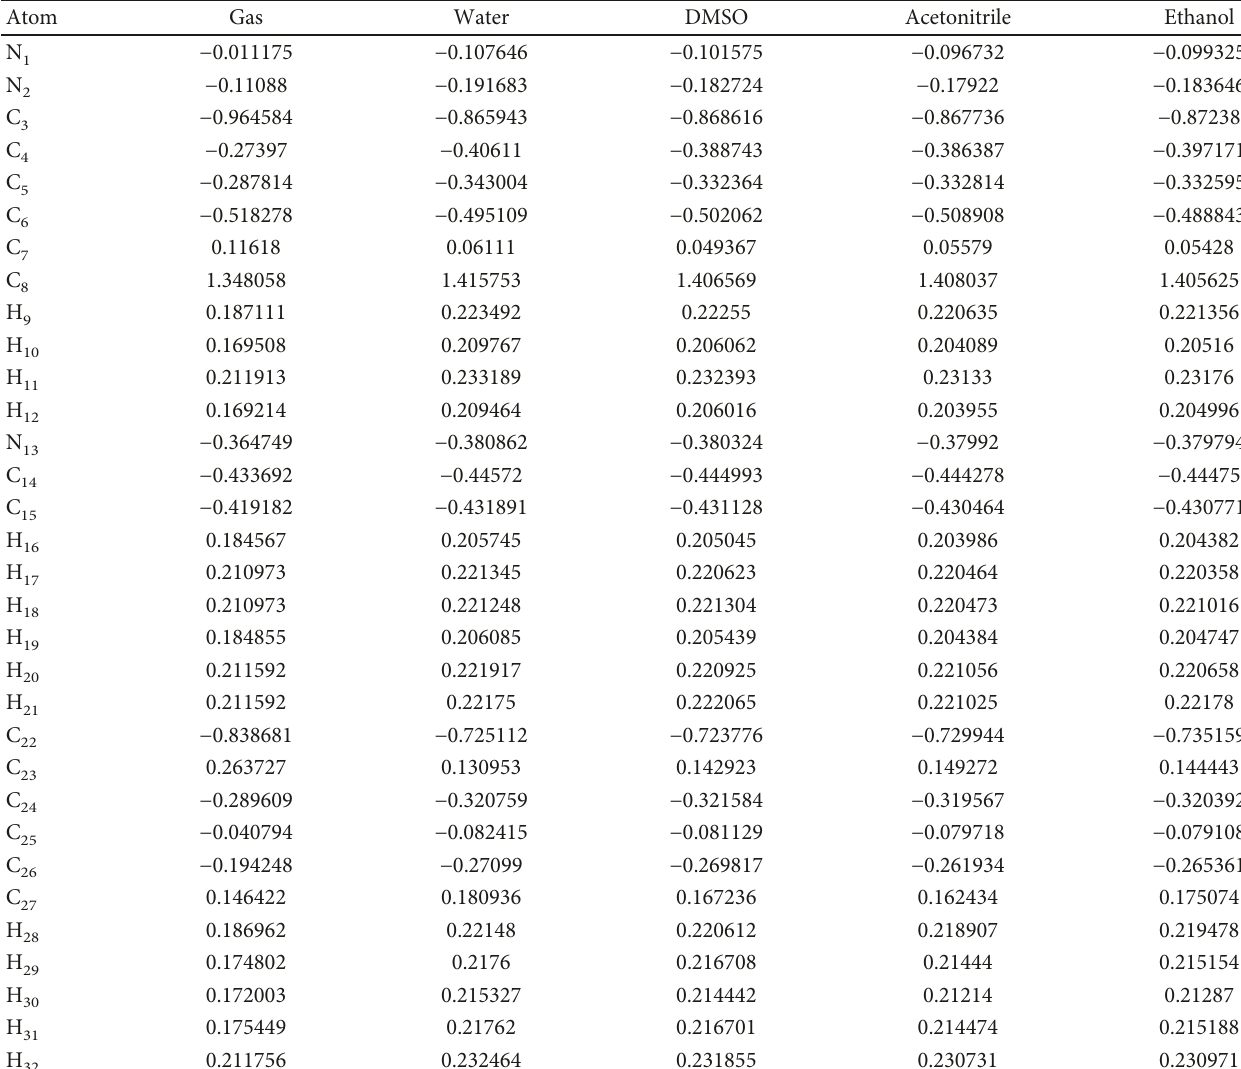
Table 7: Mulliken charge distribution at the DFT/B3LYP level using the 6-311G++ basis set in the gas phase and other solvents. Atom Gas